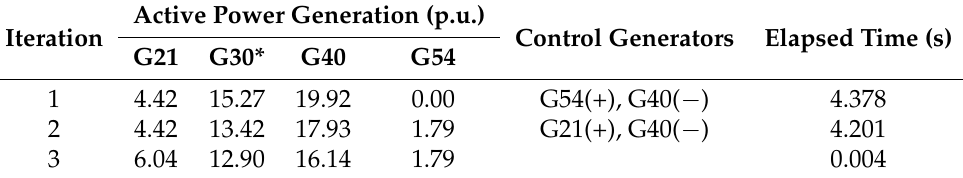
Table 3. The iteration process of adjustment for the IEEE 118-bus system.